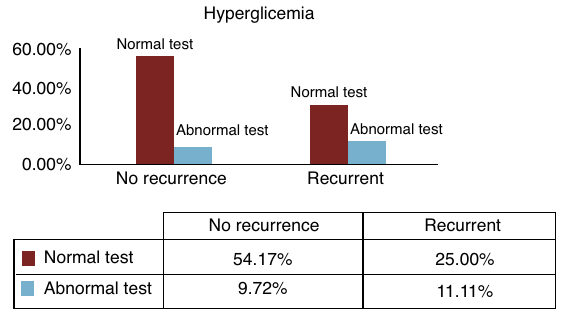
Figure 4 Distribution of patients with BPPV recurrence, regarding tests with